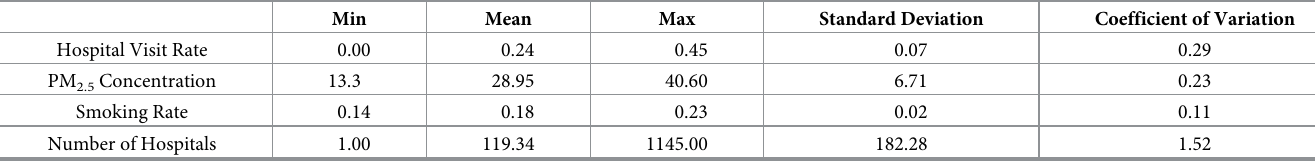
Table 3. Main descriptive statistics for hospital visit rates, PM 2.5 concentrations, smoking rates, and number of hospitals.